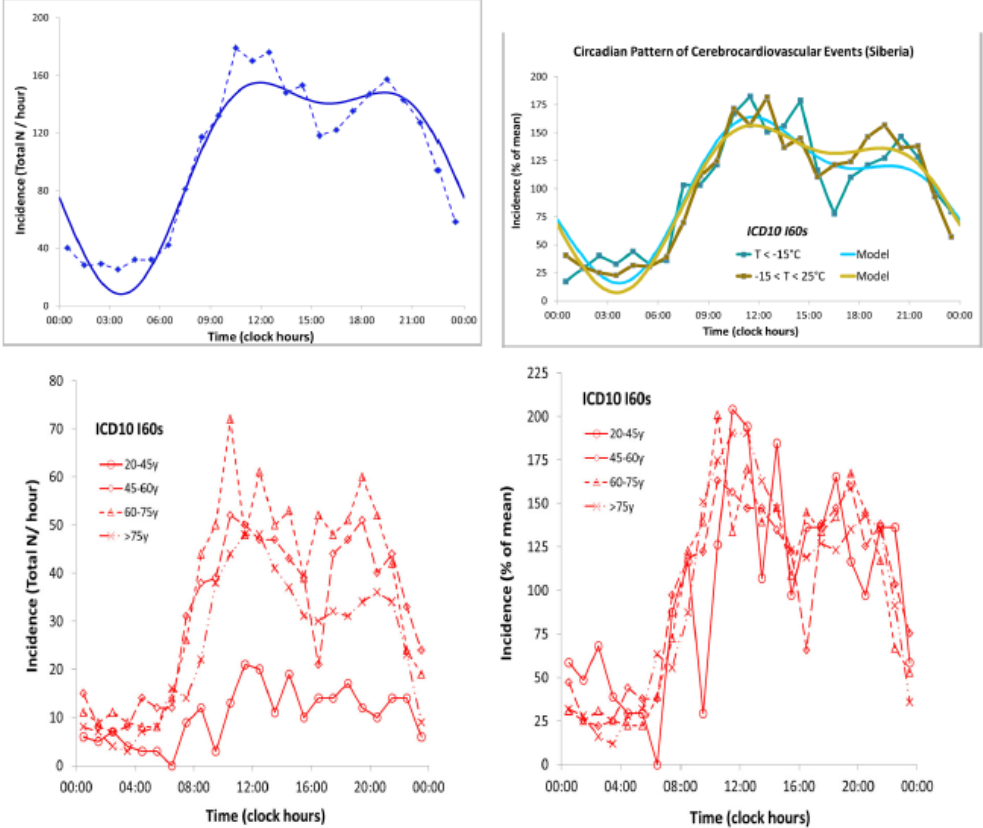
Figure 2. Circadian rhythm in the incidence of all adverse cerebrovascular events in Khanty, Siberia, during the span from 2001 to 2014 ( N = 2485) shows the morning increase with a secondary smaller peak in the evening (top left). A similar pattern is found at all age groups (bottom), notably after the data are expressed as a percentage of mean (bottom right). A similar circadian pattern is also seen irrespective of environmental temperature (top right). © Halberg Chronobiology Center